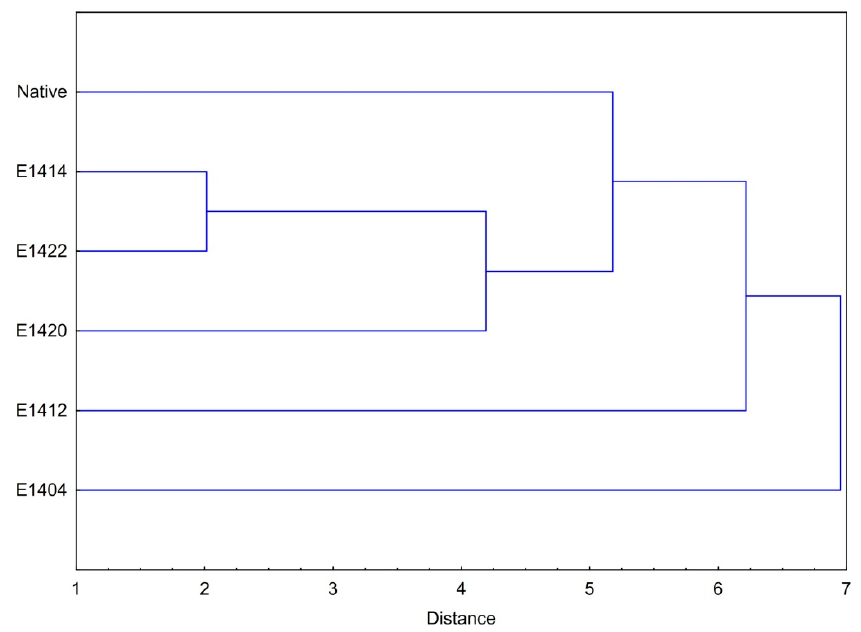
Figure 4. HCA of chemically modified potato starches.